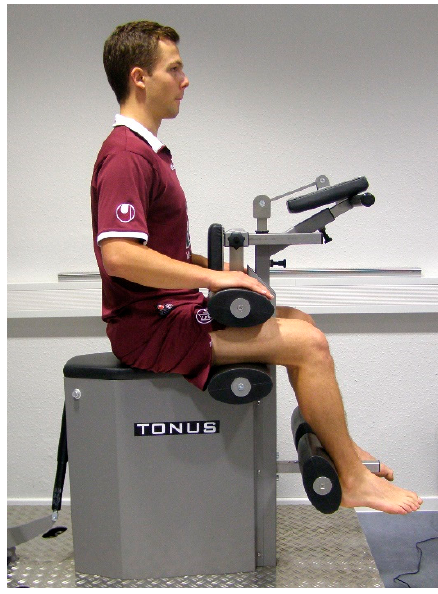
Figure 3. Measurement of the isometric torques of the hamstrings (pelvic fixation not shown).